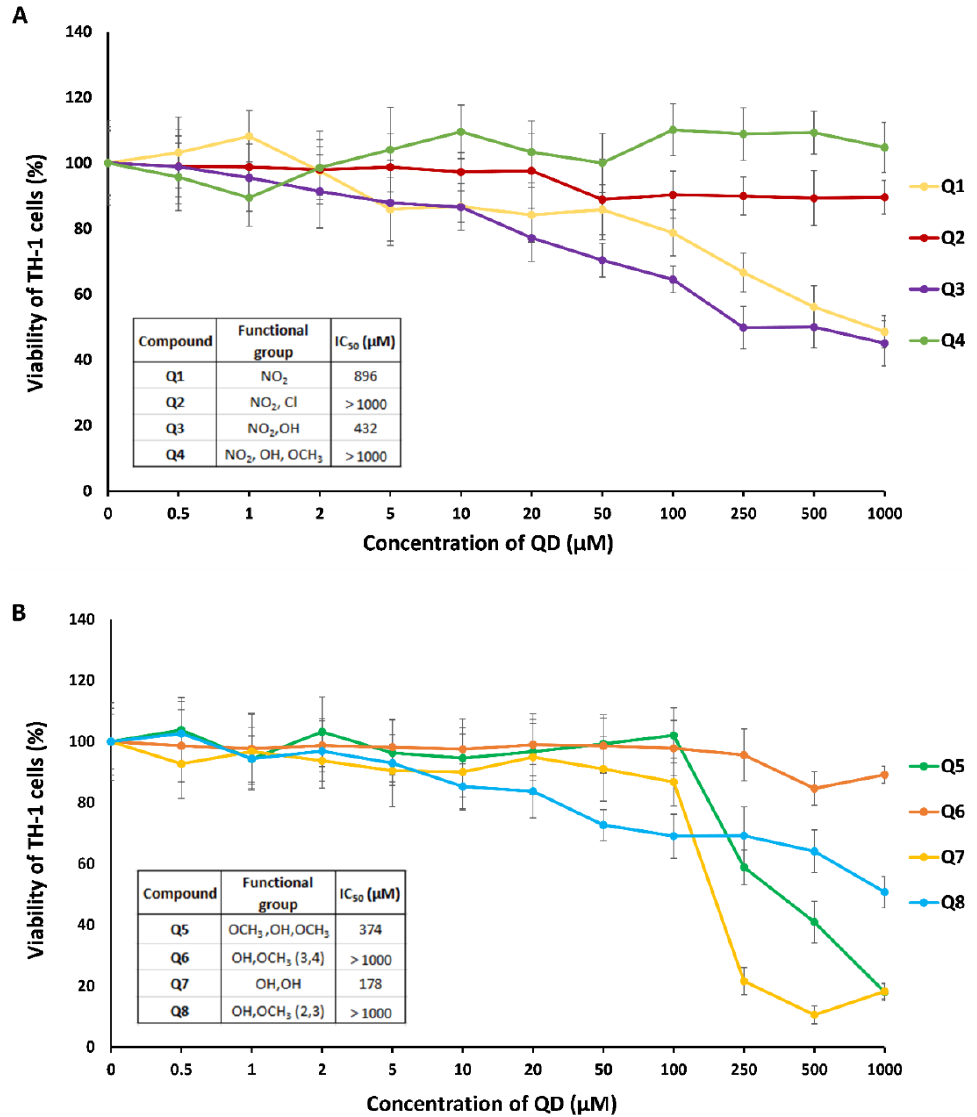
Figure 2. The cytotoxic effects of the studied quinazolinones on TH-1 cell viability after 24 h incubation; compounds Q1–Q4 ( A ); compounds Q5 – Q8 ( B ).